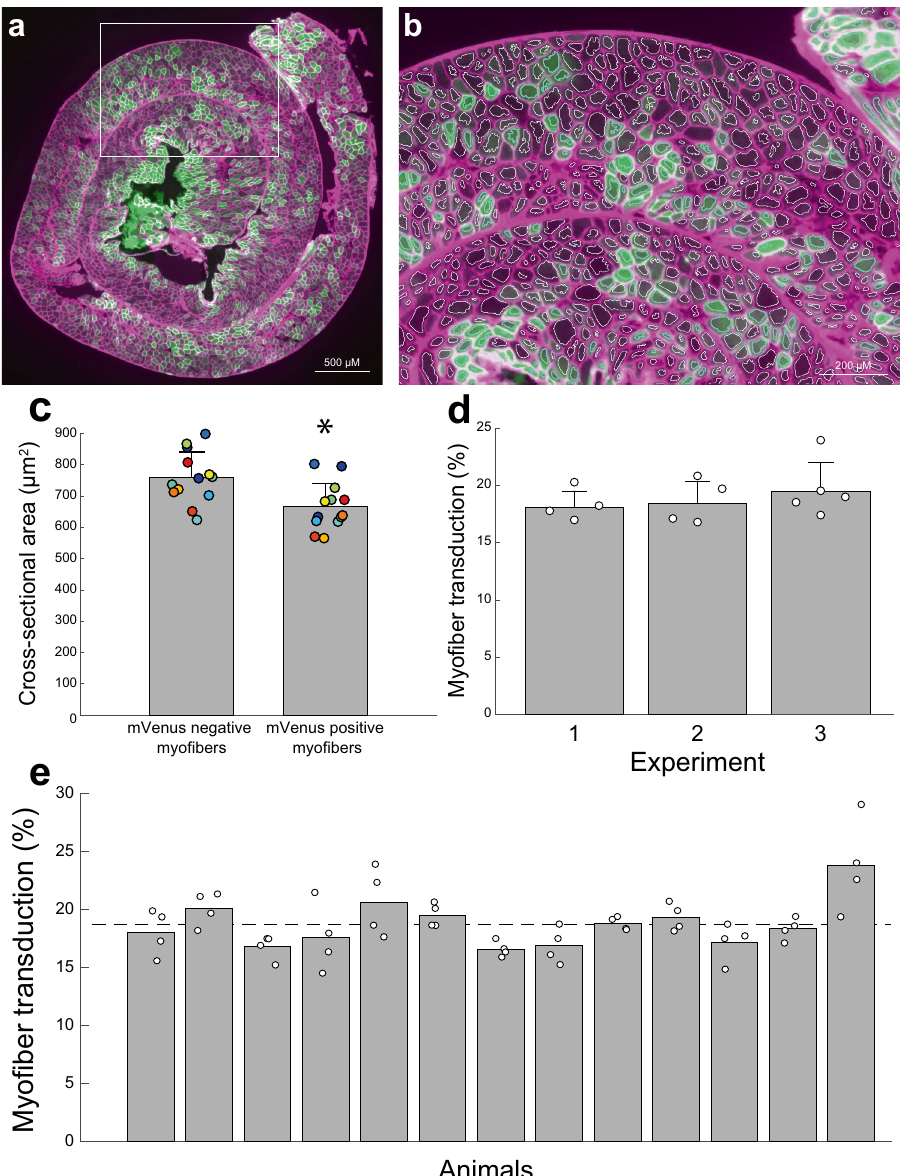
Figure 5. Transduction of diaphragm myofibers following intrapleural microinjection of AAV9. ( a ) Representative diaphragm histology. The diaphragm was rolled prior to sectioning so that cross sections enabled visualization of fibers throughout the costal region. The green myofibers show the presence of the mVenus fluorescence tag. ( b ) Inset from panel ( a ), myofibers identified by the MATLAB analysis script are outlined with white borders, mVenus positive fibers can be appreciated by the green color and are outlined with blue borders. ( c ) Diaphragm myofiber cross-section area for mVenus positive and mVenus negative myofibers. The scatter plot shows the average cross-sectional area for mVenus positive and negative myofibers from each animal (n = 13). Color of scatter corresponds to each individual animal. Wilcoxon rank sum test suggests a significant difference between cross-sectional area of mVenus positive and negative myofibers ( p = 0.008). ( d ) Comparison of diaphragm transduction across the three different experiments. One way ANOVA suggested no differences in percent transduction between experiments ( p = 0.59). ( e ) Percent transduction for each individual animals (n = 13). The scatter plot shows the data for each individual tissue section (n = 4 per mouse). The histogram shows the average for each mouse and the dotted line shows average percent transduction across all